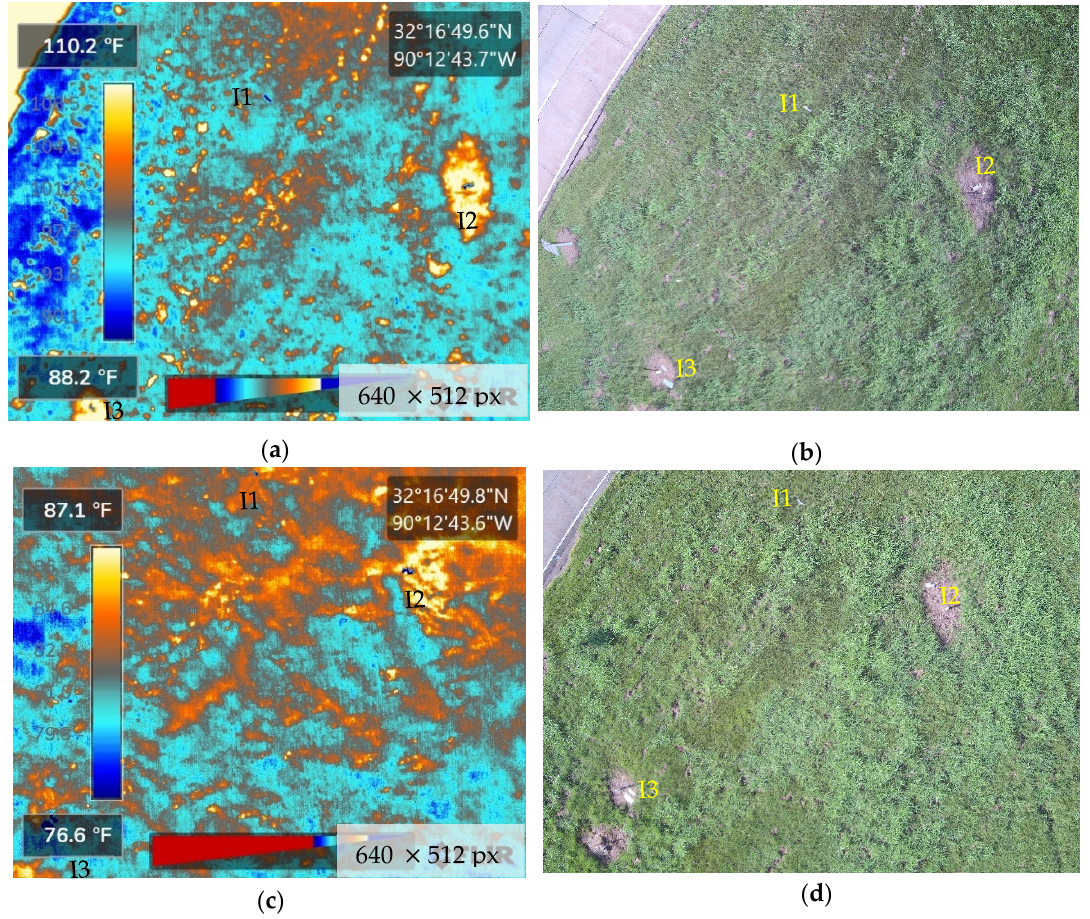
Figure 12. Thermal image and optical images at Terry Road. ( a , b ) Dawn. ( c , d ) Midday.